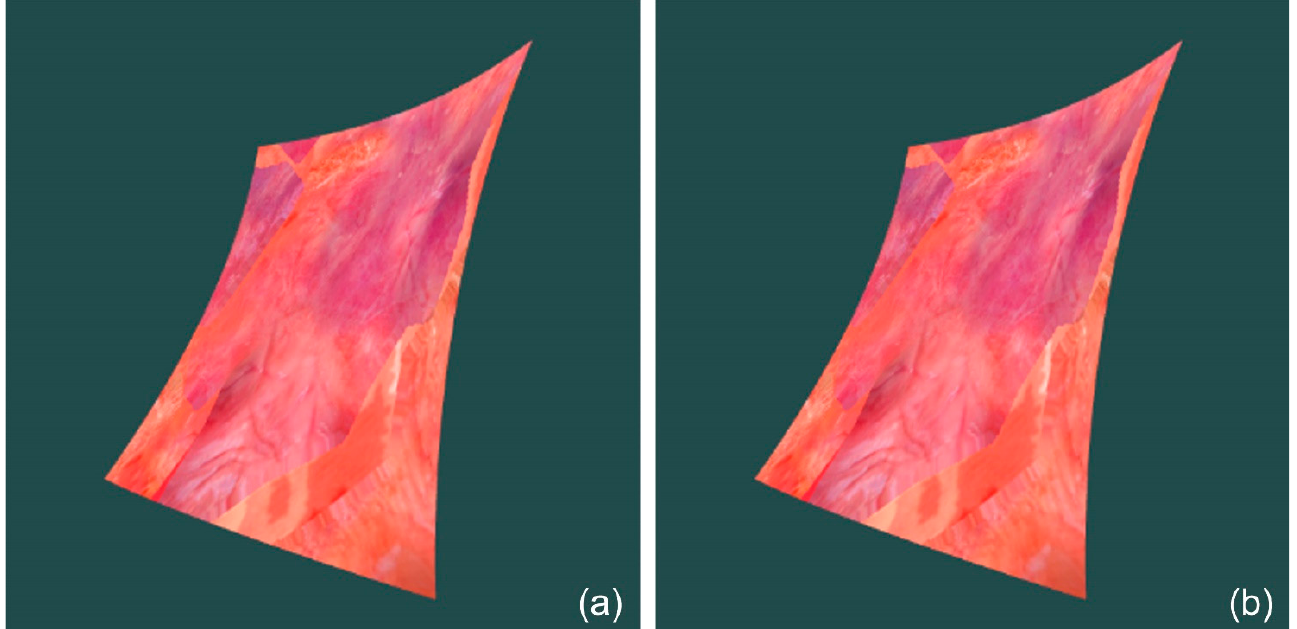
Figure 9. Comparison of two modeling methods: ( a ) repeated calculation modeling and ( b ) repara- metric modeling.